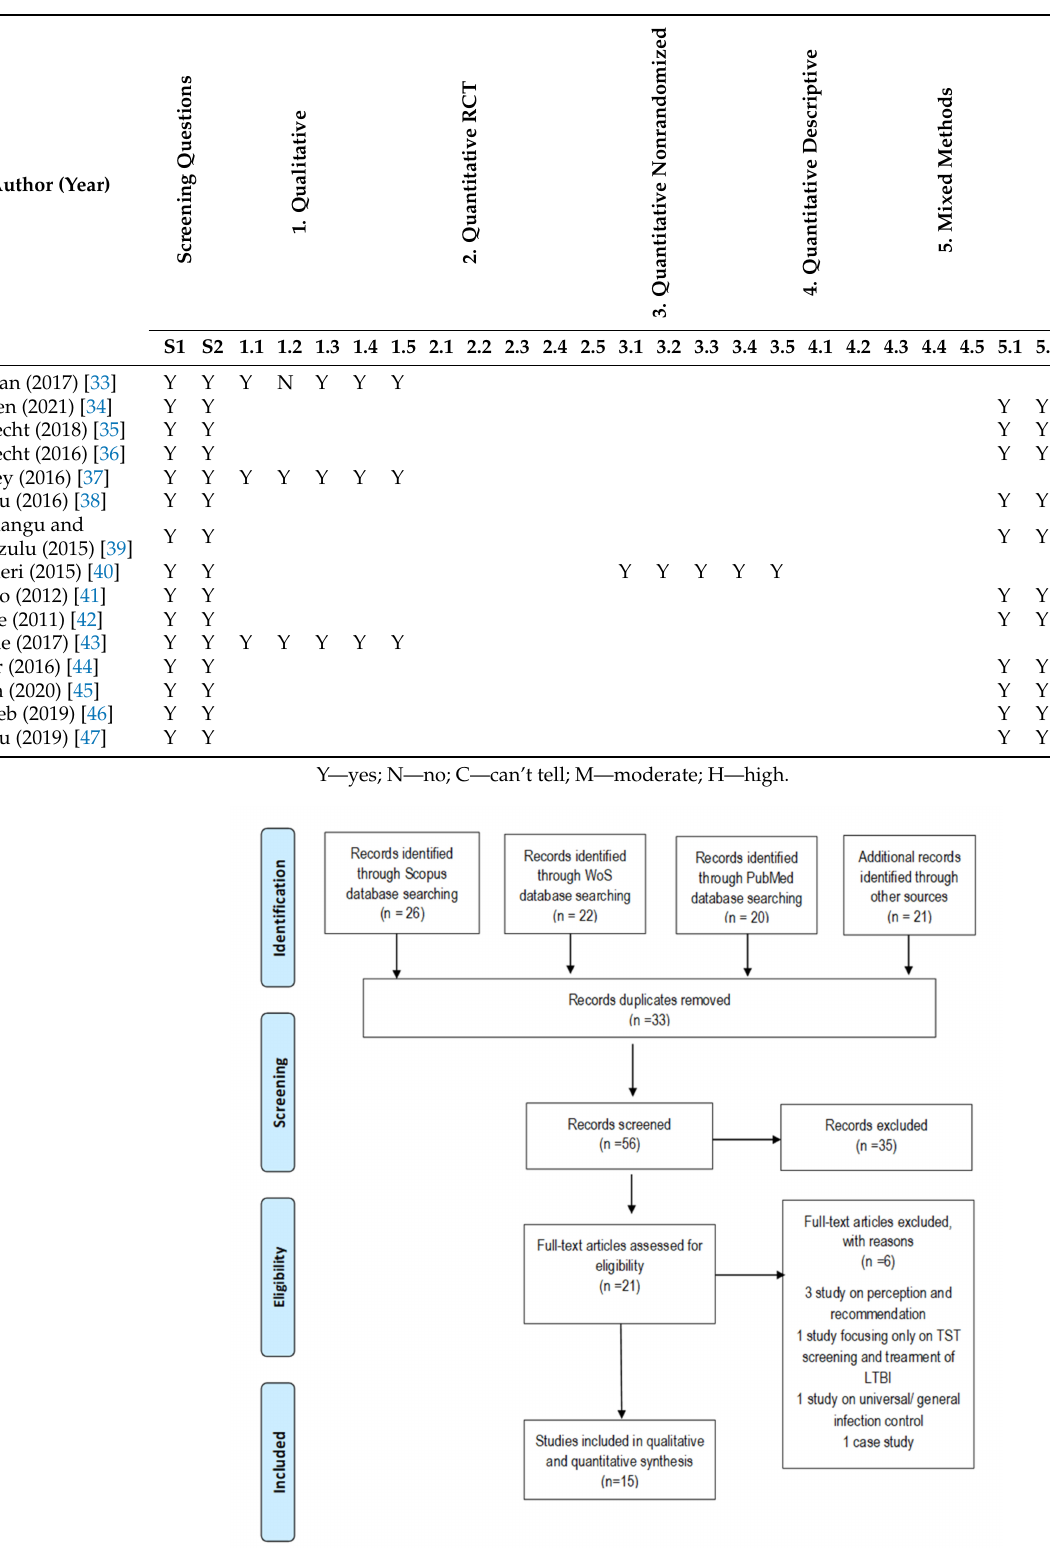
Table 4. Summary of quality appraisal grading.